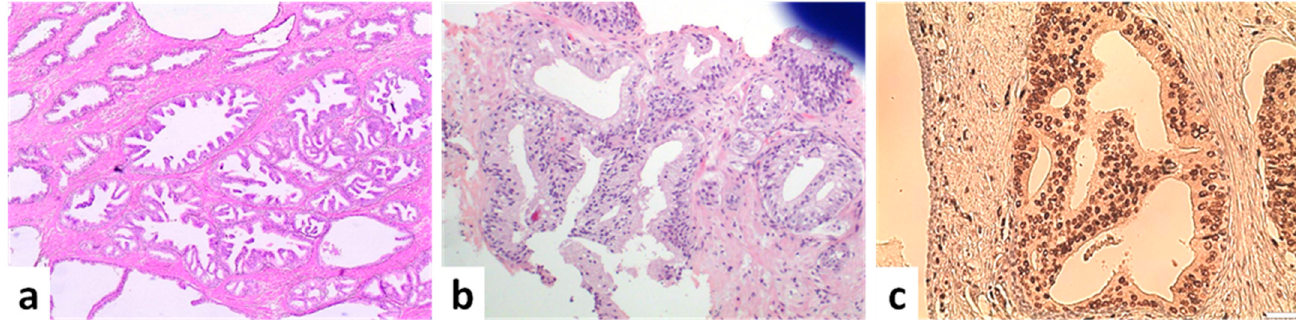
Figure 2. Preneoplastic and borderline neoplastic cribriform lesions. ( a ) Multiple foci of high-grade PIN ( × 40). ( b ) Atypical intraductal cribriform proliferation in a biopsy. Proliferation is present in <50% of the gland, located at the edge of the core and not accompanied by atypia or necrosis ( × 100). ( c ) Atypical intraductal cribriform proliferation. An expanded gland with a loose cribriform architecture is observed. Immunohistochemical expression of the marker ERG is suggestive of the malignant nature of neoplastic cells but is not enough to change the diagnosis to IDC ( × 100) (scale bar is 50 µ